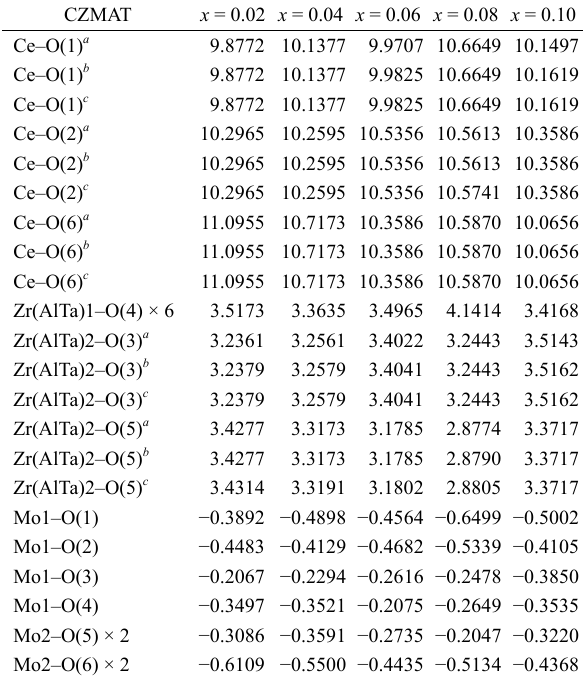
Table 5 Coefficients of thermal expansion α of CZMAT ceramics sintered at densification temperature for 6 h (Unit: 10 − 6 K –1 )